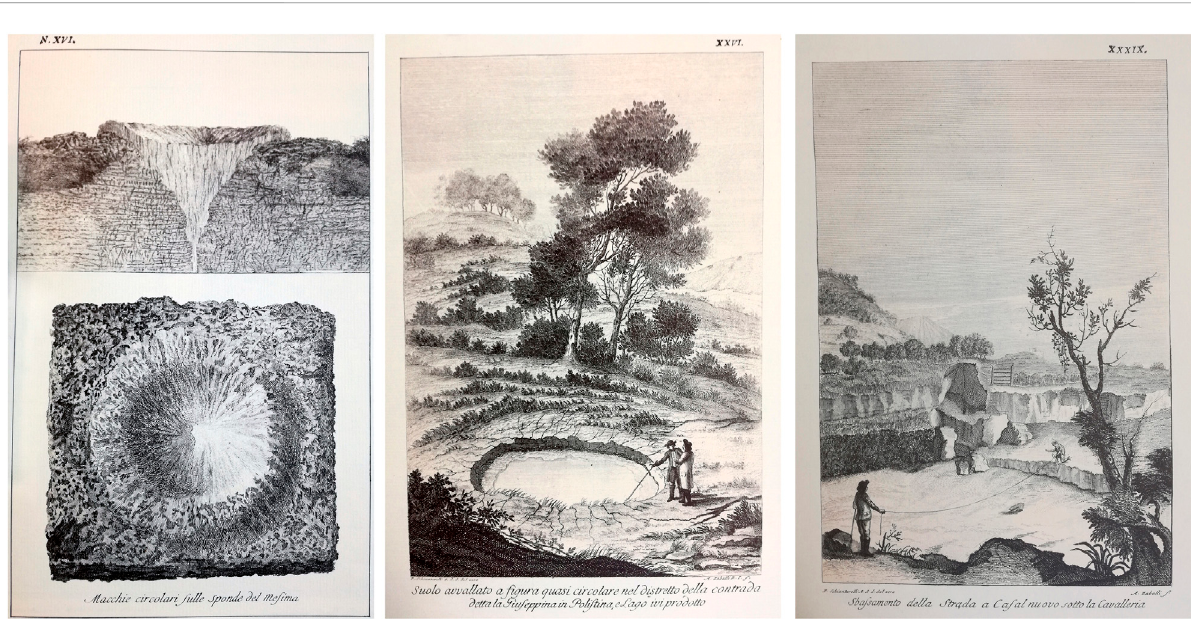
FIGURE 6 Examples of the coseimic environmental effecs reproduced by the architect Schiantarelli during the expedition headed by M. Sarconi. The left drawing faithfully illustrates a sand venting along the banks of river Mesima. The original writing below the image says “ circular spots on the banks of Mesima".This observation correspondstorecord n.14inTable2.Thecentralimage “ quasicircular depression ofthegroundnearPolistena,andlake there produced ” testi fi es of water emission and of the formation of a small lake. Two members of the expedition test the lake and measure its depth. This observation corresponds to record n. 39 in Table 2. The right etching ( “ lowering of the road to Casalnuovo ” ) shows remarkable ground ruptures near Casalnuovo (presently Cittanova). Schiantarelli and another member of the expedition take measures of the displacement across the steps of the fractures. Galli and Bosi (2002) interpreted this site as evidence of surface faulting along the Cittanova